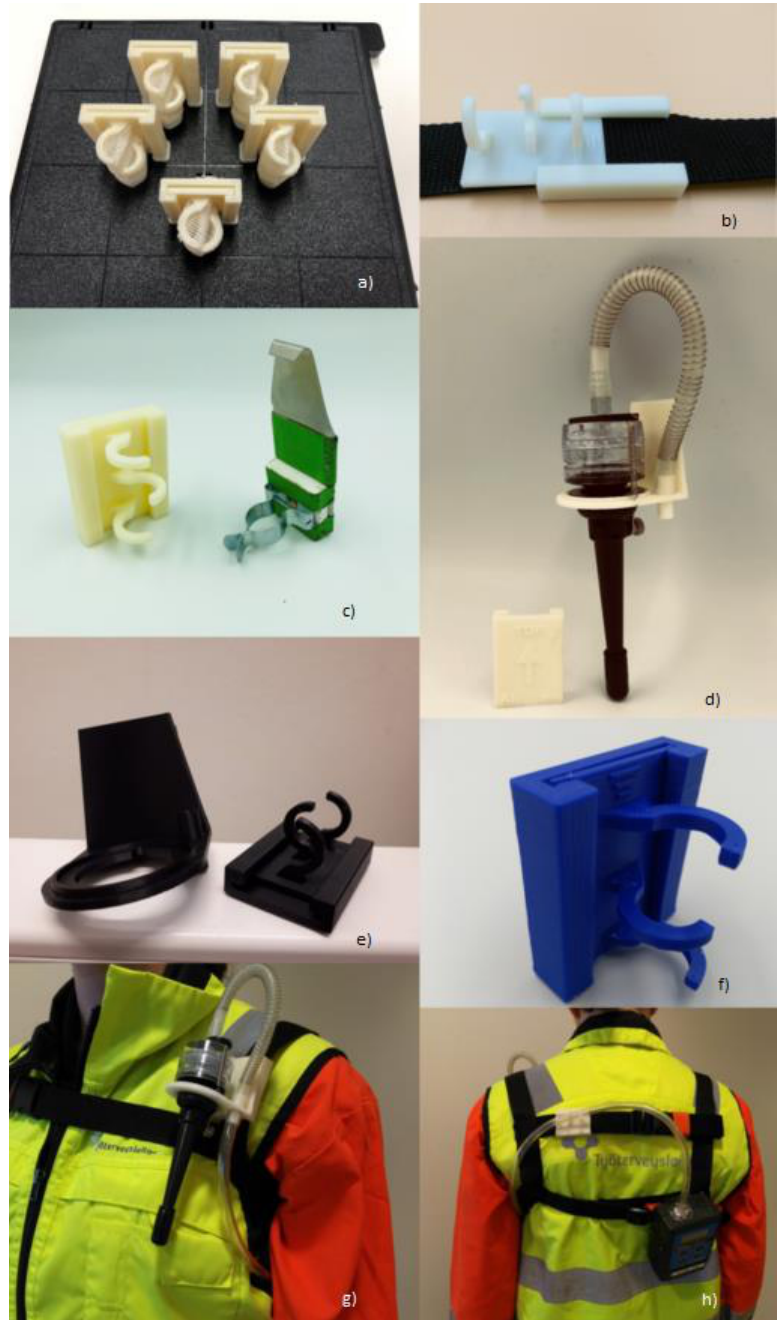
Figure 3. ( a ) Five hose holders with support structures in the printing bed; ( b ) sliding the slider into the sheath; ( c ) new (white) and old hose holder (green and metal original cyclone sampler assembly); ( d ) cyclone sampler assembly with the redesigned holder; ( e ) black hose holder clip and cyclone sampler clip printed as part of supply chain testing; ( f ) blue hose holder clip printed with Lulzbot Mini; ( g ) sampler system with cyclone sampler clip from the front; ( h ) harness with sampler system from the back.